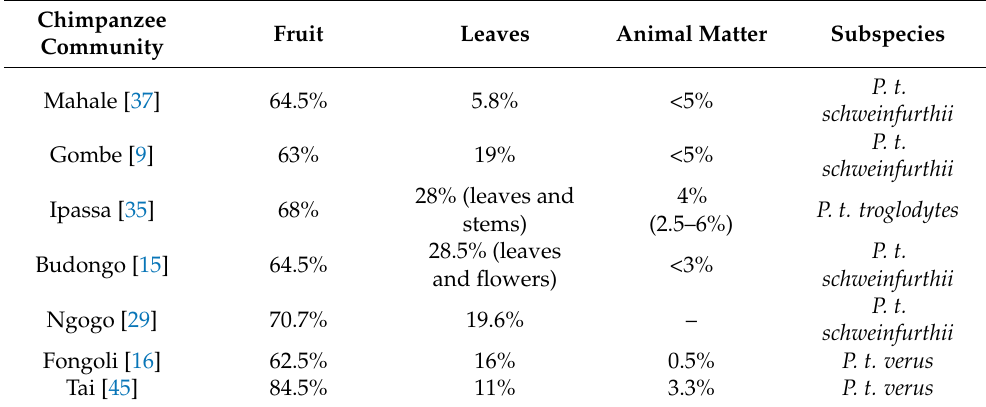
Table 2. Published estimates of diet composition in different chimpanzee communities. Diet is broken down into fruit, vegetation and animal matter consumed across different chimpanzee communities. Annual diet compositions (%) of each food category. Animal matter consists of mammal and insects. The percentage of animal matter in Ngogo diets was not found, but they do hunt more often and have high success rates compared to other large communities, which be may due to larger party sizes